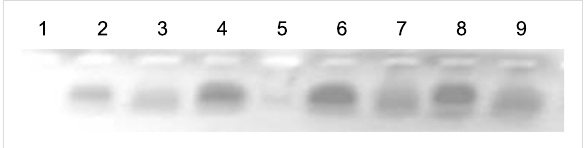
concentration from 2.5 × 10 − 3 to 2.5 × 10 − 7 M (Supporting